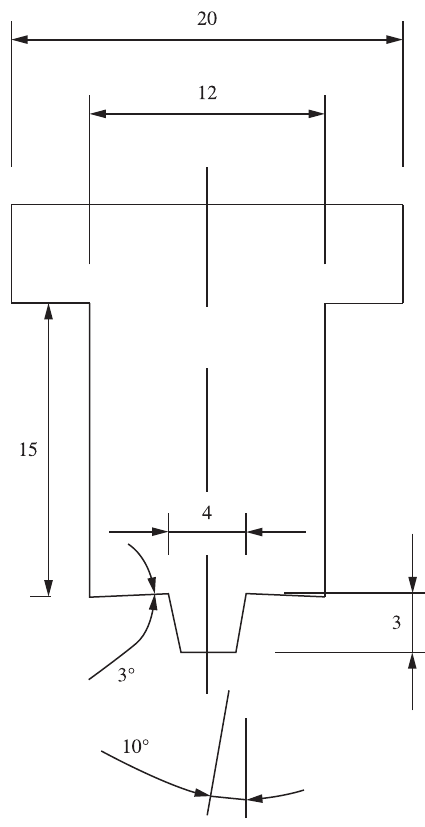
Figure 1. FSW tool (dimensions in mm).